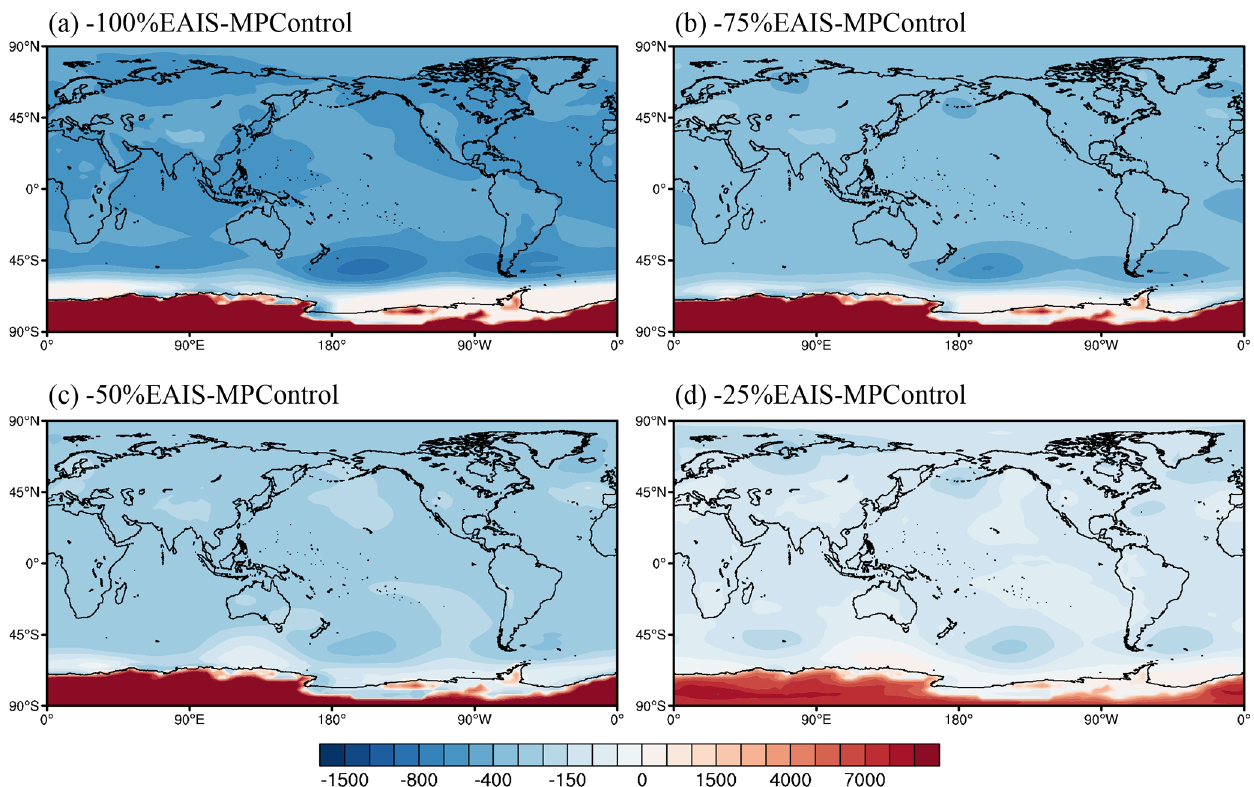
Figure 9. Spatial distribution of the annual mean surface air pressure anomalies (units: Pa) between sensitivity experiments and the MPCon- trol experiment.